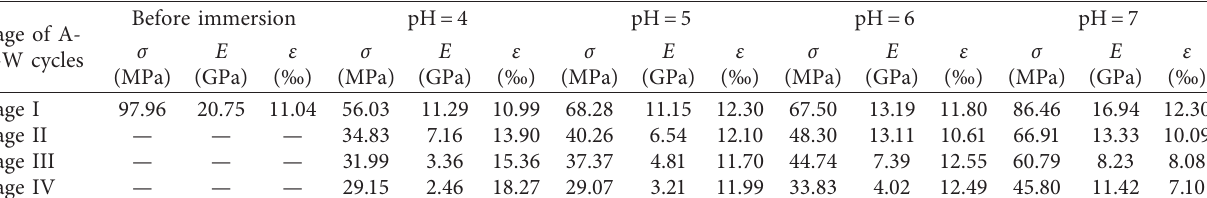
Figure 9: Stress-strain curve of sandstone specimens after A-D-W cycle: (a) pH � 4 group, (b) pH � 5 group, (c) pH � 6 group, and (d) pH � 7 group. Table 5: Mechanical parameters of sandstone specimens under various